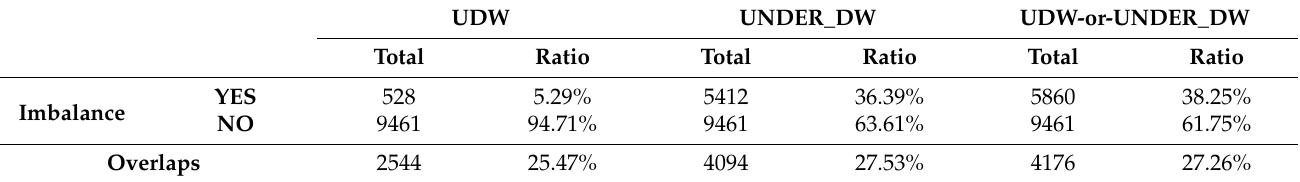
Table 3. Imbalance and overlap ratios in the final